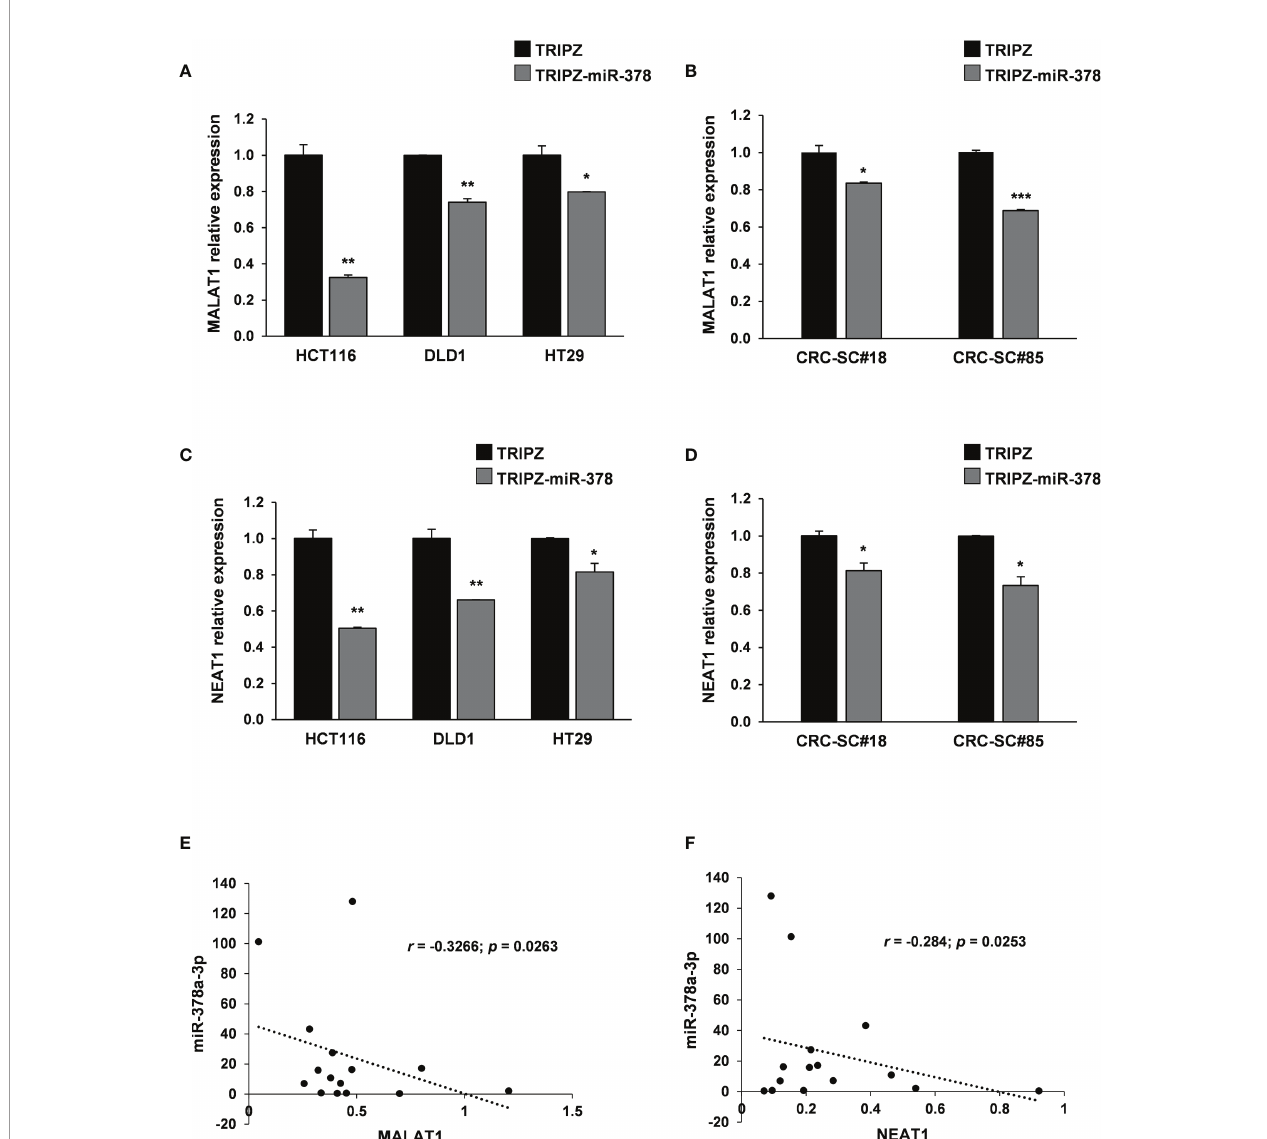
FIGURE 4 | MALAT1 and NEAT1 are modulated by miR-378a-3p and their expression is inversely correlated in CRC-SCs. MALAT1 expression was analyzed by qRT-PCR in (A) CRC cell lines (HCT116, DLD1 and HT29) and (B) CRC-SC lines (CRC-SC#18 and CRC-SC#85) transduced with TRIPZ or TRIPZ-miR-378 inducible vectors after doxycycline exposure. qRT-PCR analysis for MALAT1 con fi rmed the downregulation of the lncRNA. NEAT1 expression was analyzed by qRT- PCR in (C) CRC cell lines (HCT116, DLD1 and HT29) and (D) CRC-SC lines (CRC-SC#18 and CRC-SC#85) transduced with TRIPZ or TRIPZ-miR-378 inducible vectors after doxycycline exposure. qRT-PCR analysis for NEAT1 con fi rmed the downregulation of the lncRNA. (E) Correlation analysis between miR-378a-3p and MALAT1 expression levels in CRC-SC lines (p=0.0263). (F) Correlation analysis between miR-378a-3p and NEAT1 expression levels in CRC-SC lines (p=